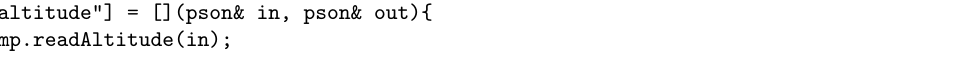
Figure 15. Input/Output